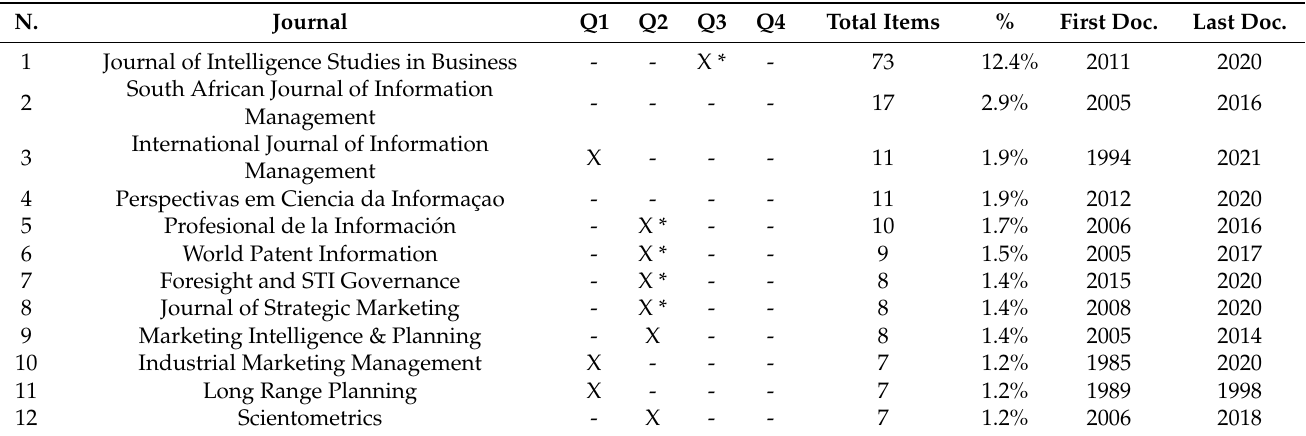
Table 2. Journals that have published on Competitive Intelligence. Quartile 2019 and Total Items.